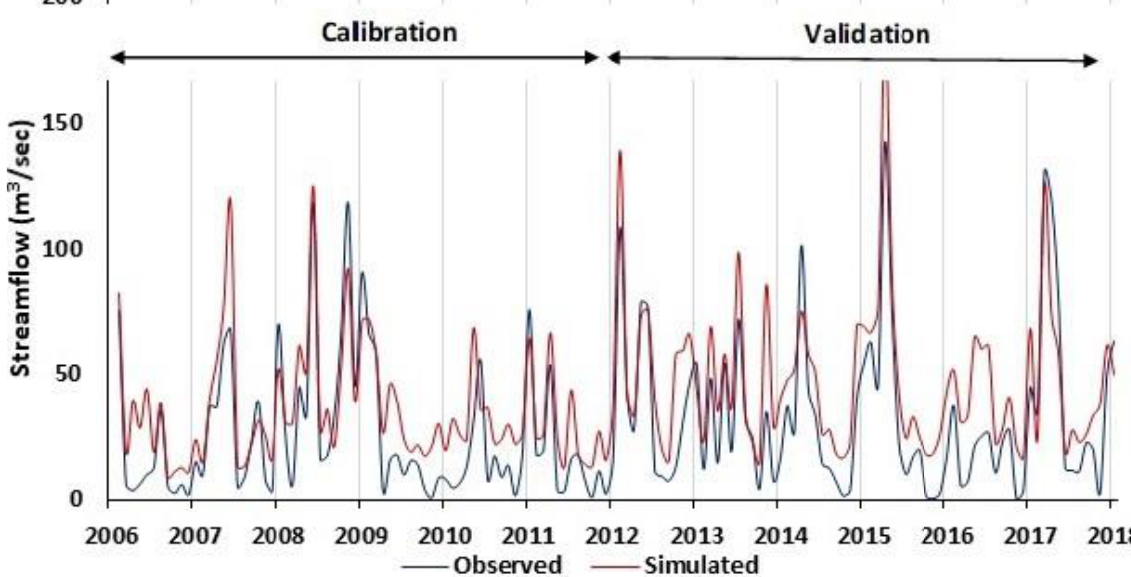
Figure 2. Comparison between observed and simulated streamflow during calibration and validation at sunflower gauge of BSRW . Table 1. Calibration and validation statistics for streamflow, sediment, TN and TP load at three USGS gauges of BSRW .